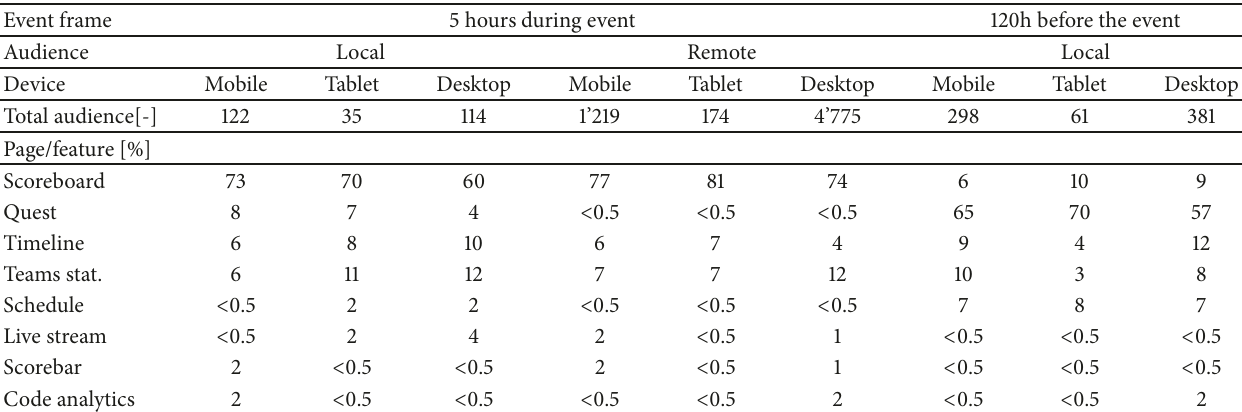
Table 7: Time on page by device, time fragment, and